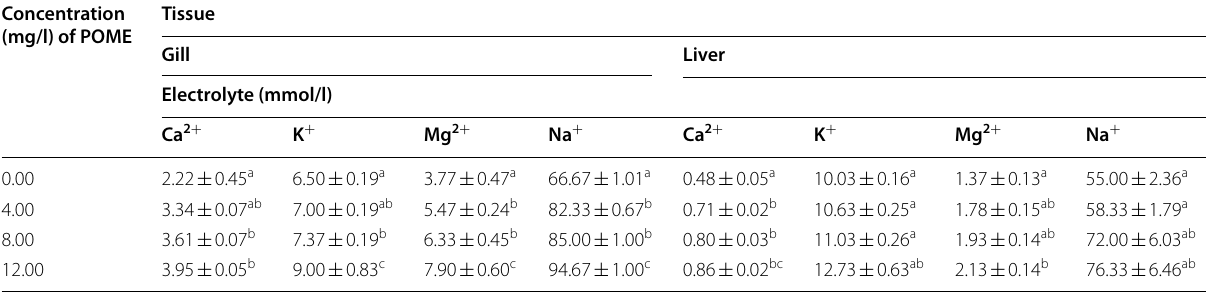
Values are means SD of 3 replicates. Values along the same column with different superscript are significantly ( P < 0.05) different ± Ca 2 + calcium, K + potassium, Mg 2 + magnesium, Na + sodium